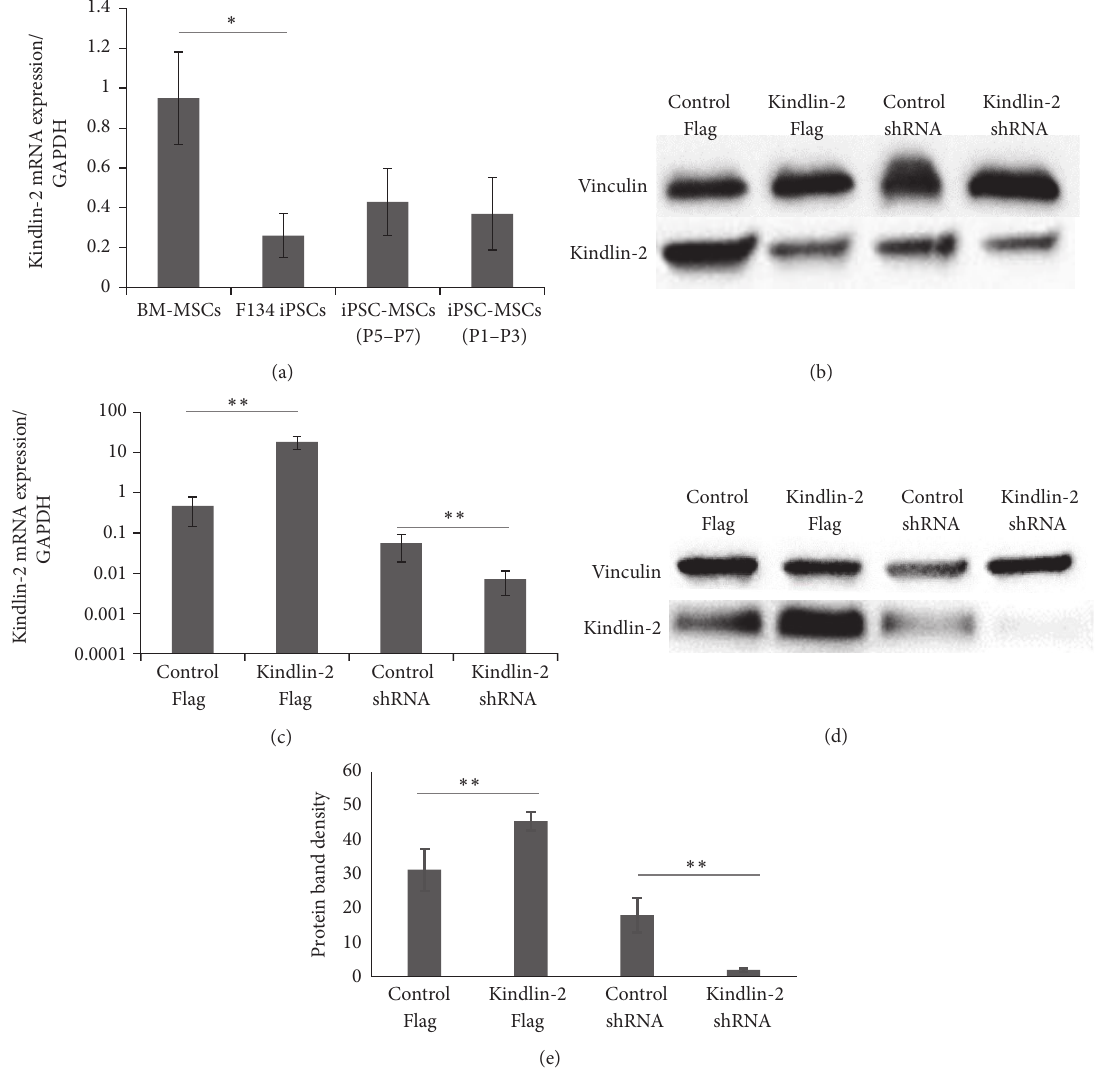
(means + SD; 𝑛 = 3 ; not shown in figure). Thus,